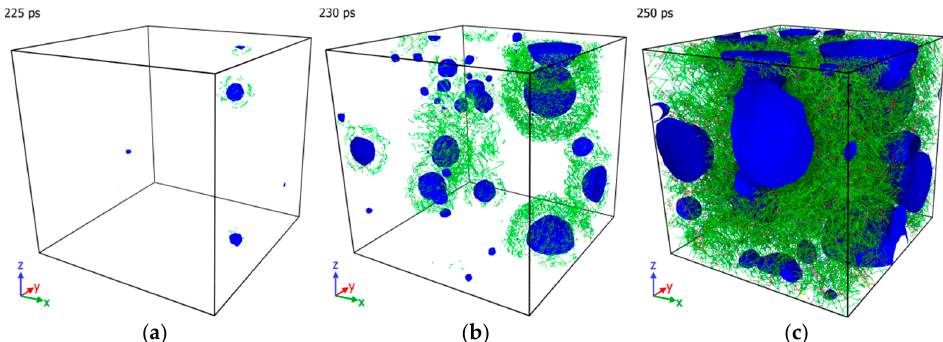
Figure 1. MD simulations of the dynamic tensile fracture of copper at room temperature (300 K): ( a ) Homogeneous nucleation of voids coated by dislocations; ( b ) Abrupt plastic growth of voids with the dislocation coats indicating zones of plastic flow around the voids; ( c ) Intersection of the plastic flow zones. The void surfaces and dislocation lines are shown; MD system with 13.5 million atoms.